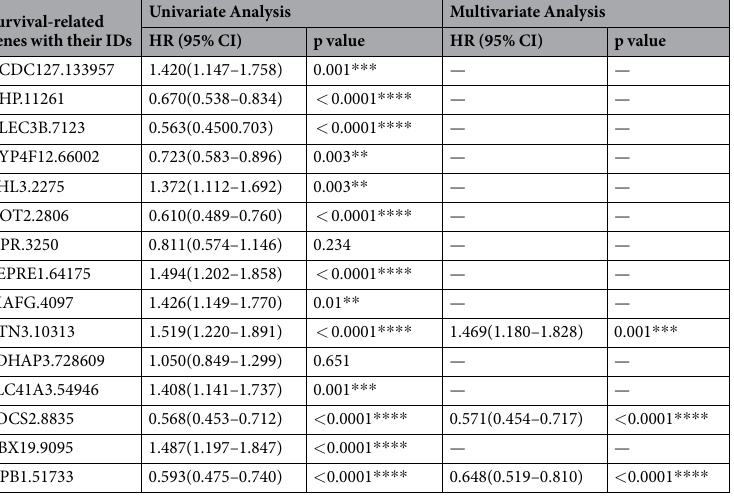
Table 2. Univariate and multivariate cox regression analysis of the survival-related genes. Variables with p < 0.1 in univariate analysis were included in the multivariate analysis using a forward conditional method. Gene symbol is in front of the dot, and the numbers behind the dot is the Entrez Gene ID. Abbreviations: CI, confidence interval; HR, hazard ratio. Statistical significance is marked with the star symbol: ** p < 0.01, *** p < 0.001, **** p <